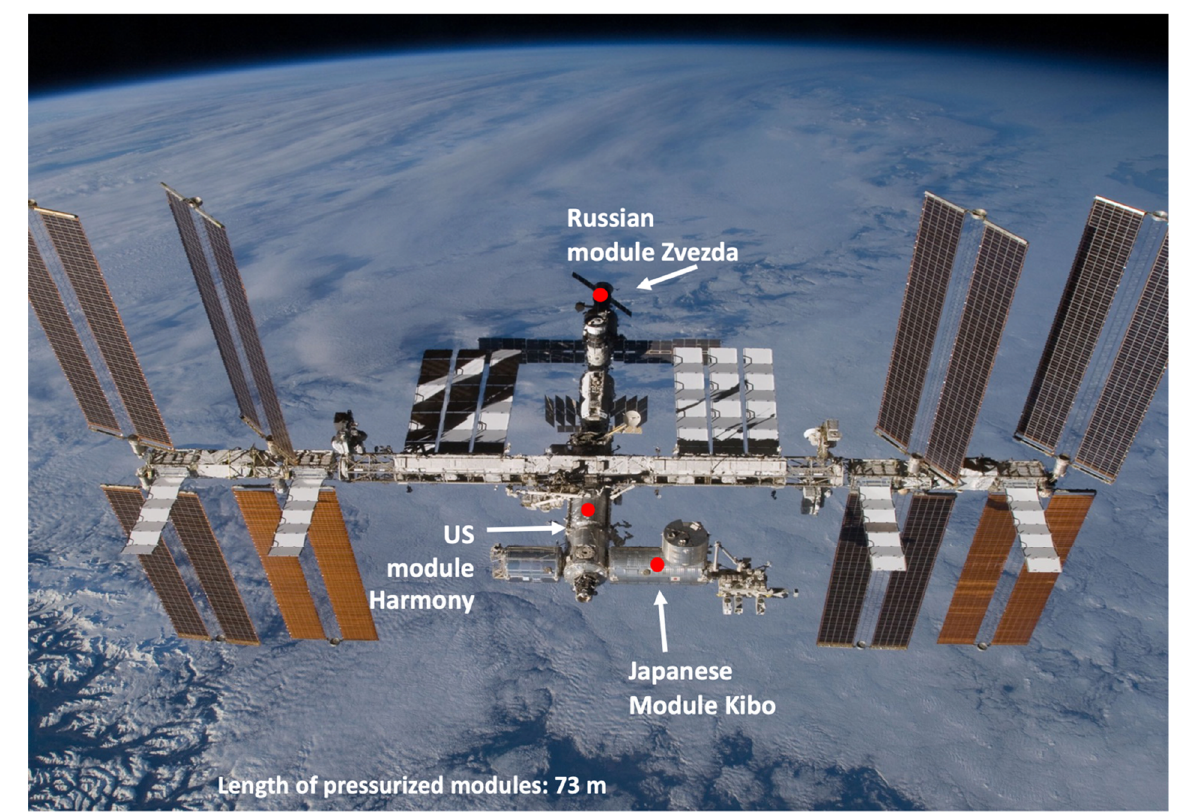
Figure 1. International Space Station in which the Russian, US and Japanese modules are indicated (red dots). In these modules Bacillus strains were recovered during microbiological surveys. Credit: NASA, https://www.nasa.gov accessed on 1 December 2020.